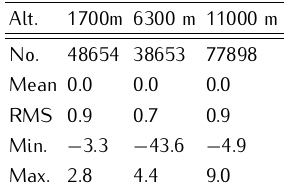
Table 3. Statistics of the misfit by 3D Fourier series. Units in mGal